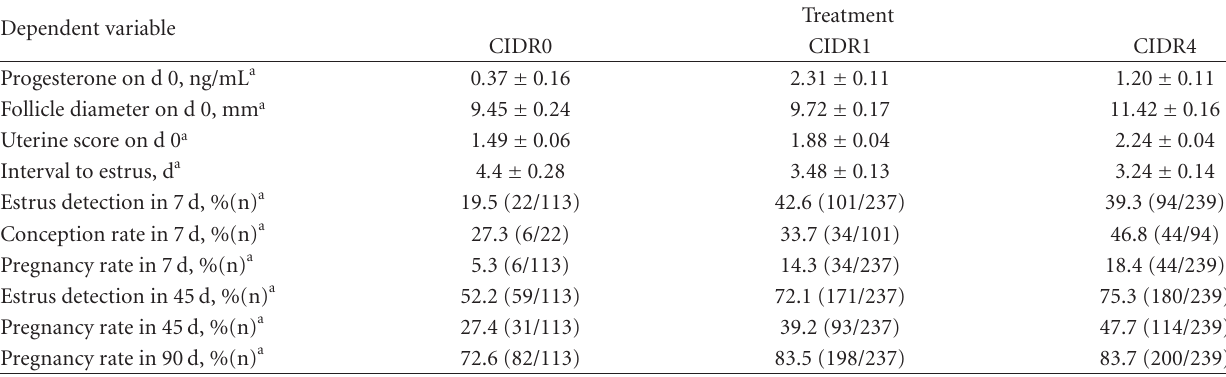
Table 4: Reproductive endpoints in prepubertal Bos indicus heifers that received, between d-12 and 0, no treatment (CIDR0), a new intravaginal insert containing 1.9g of progesterone (CIDR1), or a similar intravaginal insert that had previously been used three times (CIDR4). The breeding season started on d 1 and consisted of AI after estrus detection between d 1 and 45 and exposure to bulls between d 46 and 90. Adapted from Claro J´unior et al.